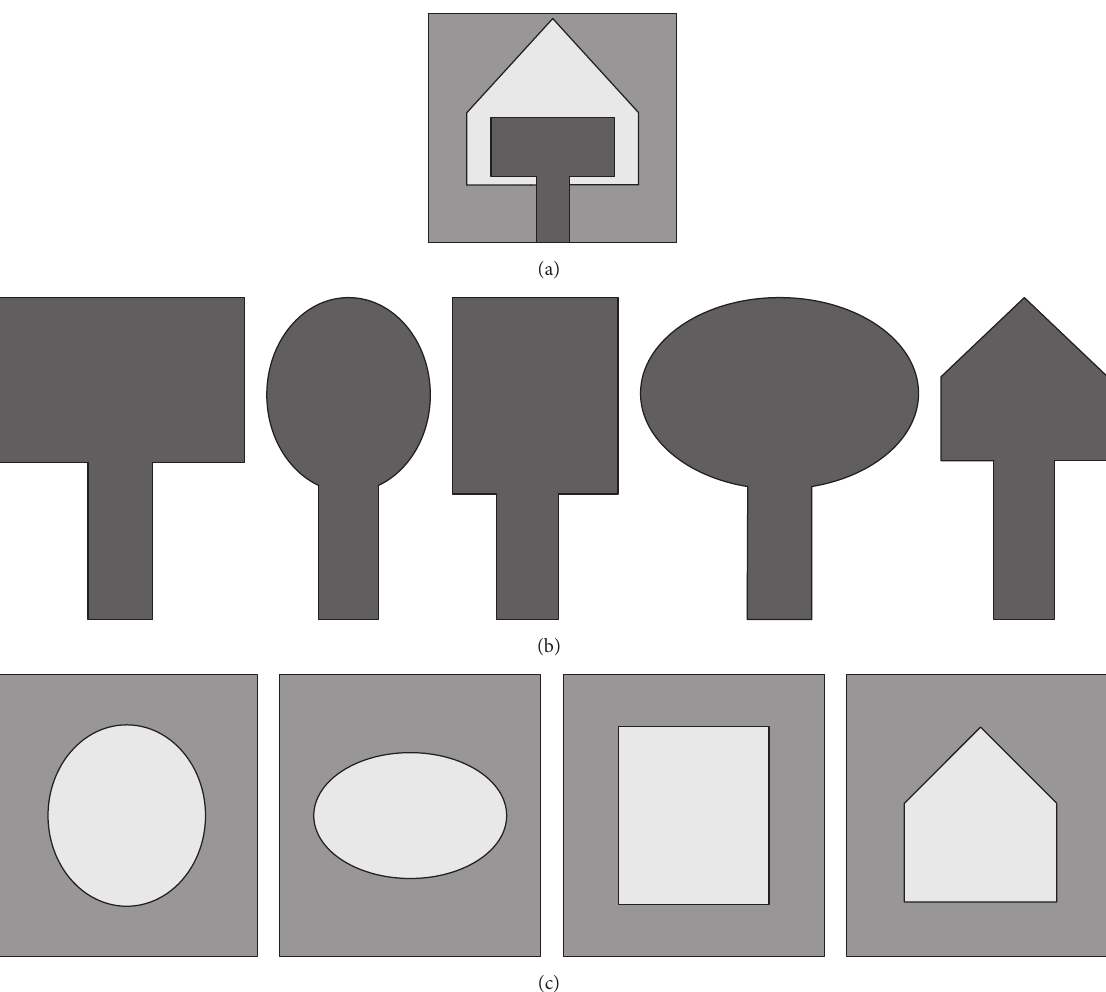
Figure 26: Example of a printed wide-slot monopole antenna (a) [91]. Monopole shapes (b) and frame geometries (c) adopted to realize printed wide-slot monopole antennas. Dark gray upper metal face, medium gray bottom metal face, and light gray dielectric substrate.